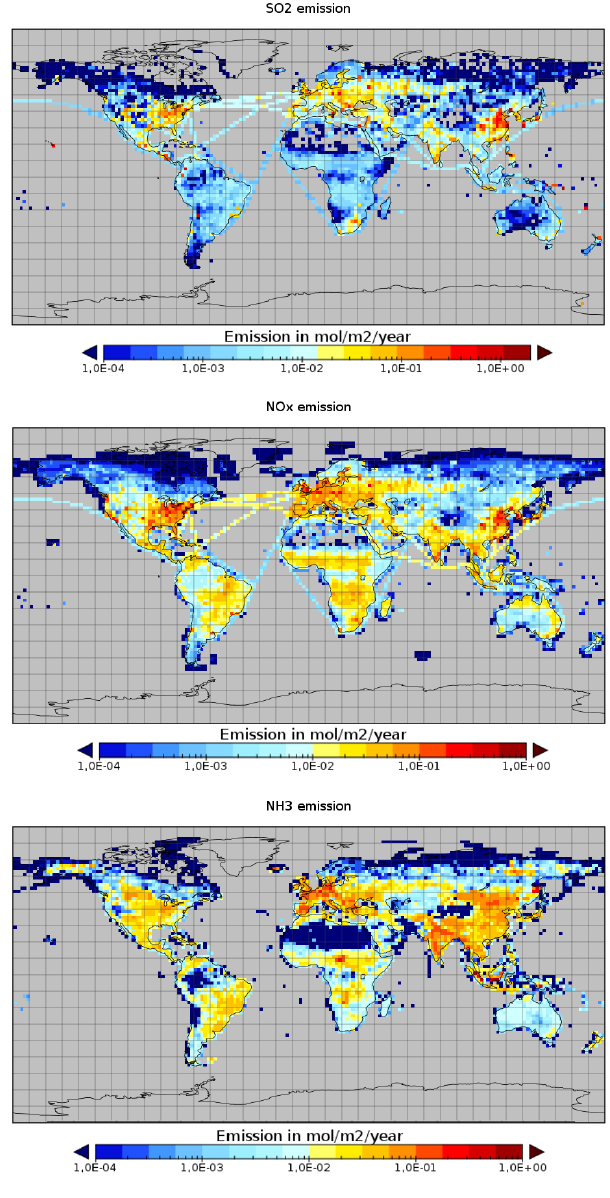
Figure 3. Maps of 2005 annual emissions of sulfur dioxide (SO 2 ) (top panel), nitrous oxides (NO x ) (middle panel) and ammonia (NH 3 ) (bottom panel), in molm − 2 year − 1 for the MOCAGE simu- lations (RACM and